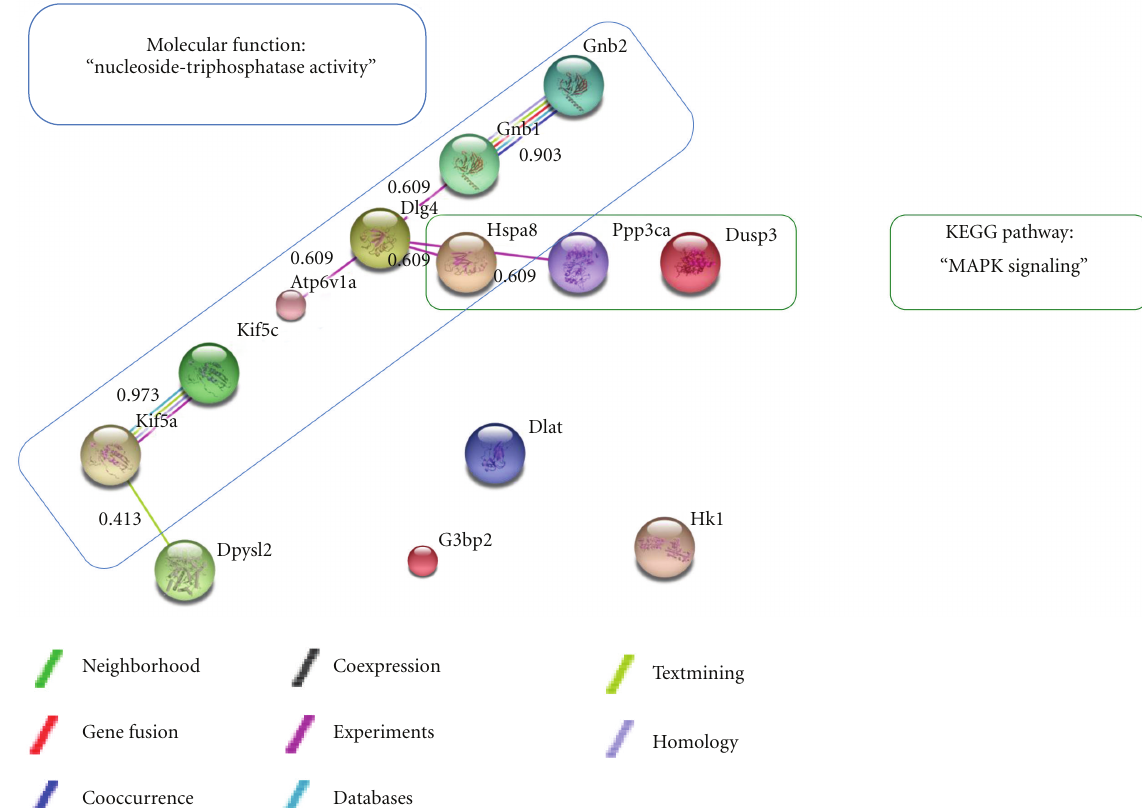
Figure 2: Bioinformatic analysis of the di ff erentially expressed proteins.The list of the MS-identified protein spots from 2D-DIGE was subjected to String (v. 8.3) analysis to reveal functional interactions between the deregulated proteins. Interacting proteins are connected by lines of di ff erent colors, according to the color code shown at the bottom of the figure. The reported values close to the lines indicate the confidence scores, as revealed by the functional interaction analysis. The original graphic output was modified to fit the proteins in the blue and green boxes, according to their classification under the gene ontology descriptors “Molecular function: nucleoside triphosphatase activity” and “KEGG pathway: MAPK signaling pathway,” as revealed by the DAVID (v. 6.7) annotation